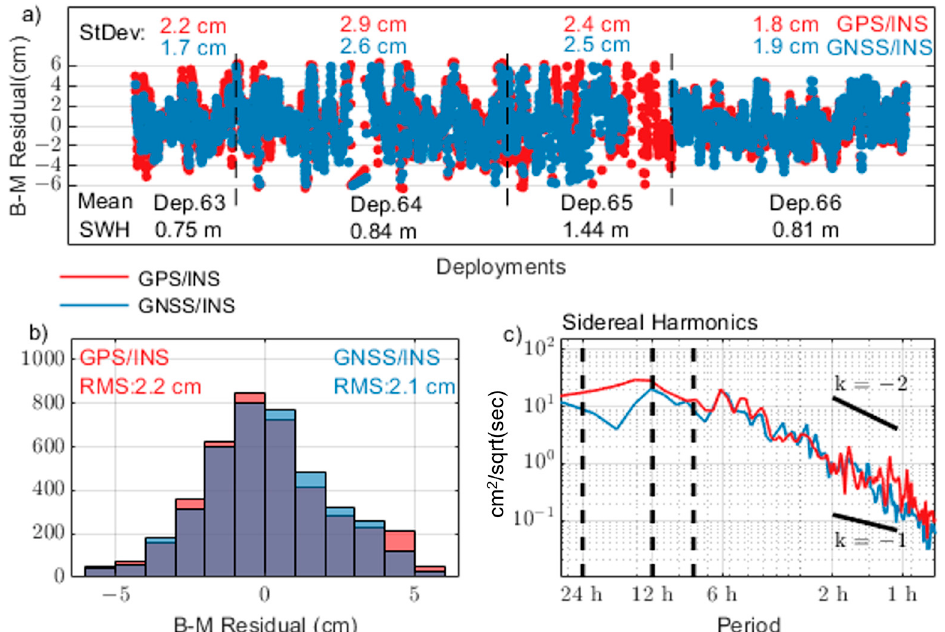
Figure 4. Statistics of B-M residuals for deployment 63 to 66. Panel ( a ) shows the buoy-minus- mooring (B-M) residuals across four deployments. Standard deviations of residuals are calculated over the common period in cases of gaps and outages and shown in the same colours as the two types of solutions: GPS/INS (red), GNSS/INS (blue). Panel ( b ) shows the distribution of the B–M residuals before and after the introduction of GLONASS. Panel ( c ) shows the power density spectra. Sidereal day harmonics are the vertical dotted lines, while reference lines for flicker (k = − 1) and random walk (k = − 2) noise are shown.